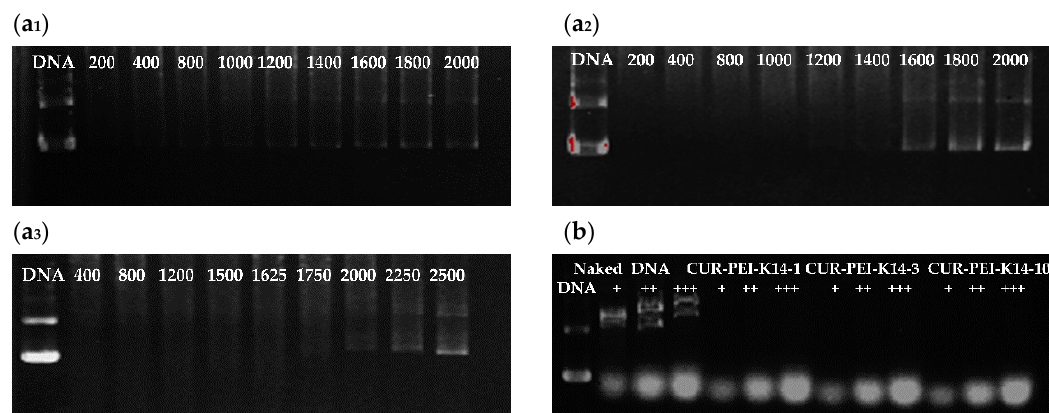
Figure 5. Protection of ( a 1 ) CUR-PEI-K14-1, ( a 2 ) CUR-PEI-K14-3, and ( a 3 ) CUR-PEI-K14-10 on pDNA from dissociation by sodium heparin at varying concentrations ( μ g/mL). Protection of ( b ) CUR-PEI-K14 on pDNA from dissociation by serum at varying concentrations. The “+” means the serum at concentration of 25%, “ ++ ” means the serum at concentration of 50%, and “ +++ ” means the serum at concentration of 75%.